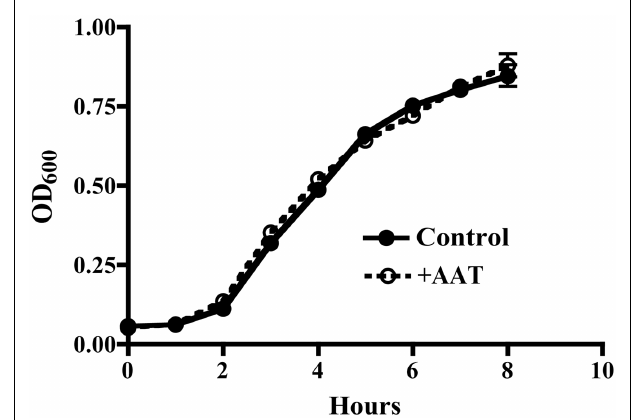
FIGURE 4 |AAT effect on P.aer replication in suspension cultures . P.aer bacteria were inoculated into LB broth cultures in the absence (Control, closed circles with solid line) or presence of 5mg/mL AAT ( + AAT, open circles with dashed line) and incubated in a shaking incubator for 8h at 37°C.The optical density (OD 600 ) of the cultures was measured hourly.The means ± SEM OD values are shown from three separate experiments.